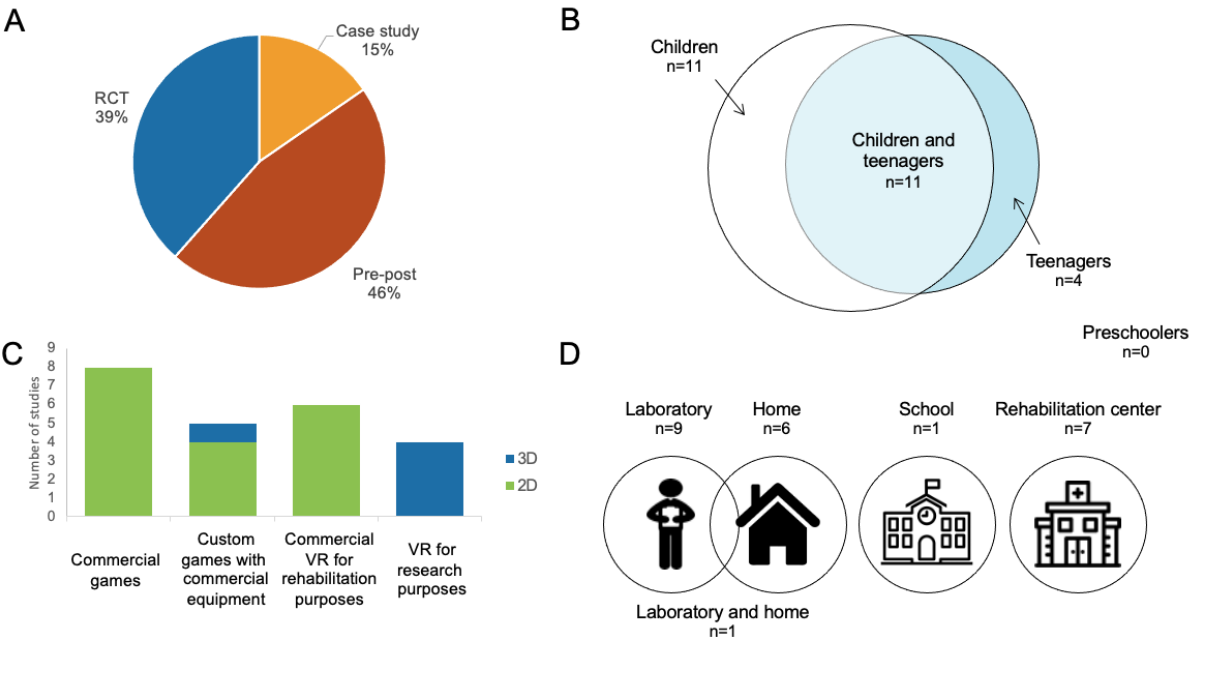
Figure 2. Characteristics of the reviewed studies according to (A) study design, (B) participants’ age groups (preschoolers: aged 0-4 years; children: aged 4-12 years; teenagers: aged 13-18 years), (C) virtual reality (VR) system type, and (D) delivery environment. RCT: randomized controlled